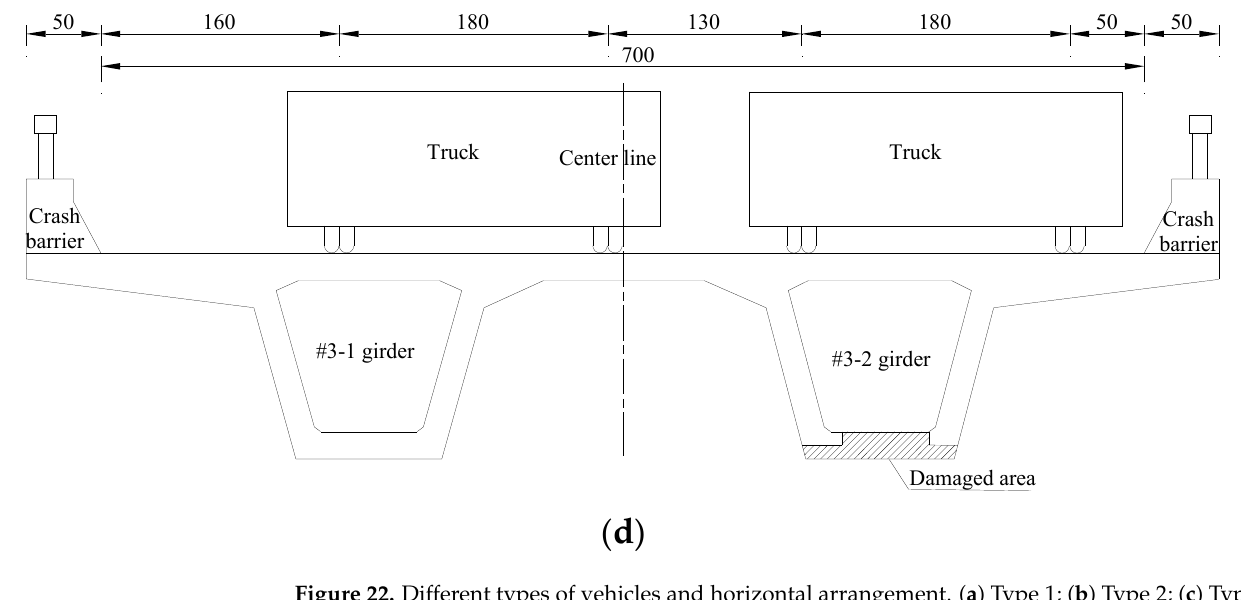
Figure 22. Di ff erent types of vehicles and horizontal arrangement. ( a ) Type 1; ( b ) Type 2; ( c ) Type 3; ( d ) Horizontal arrangement.